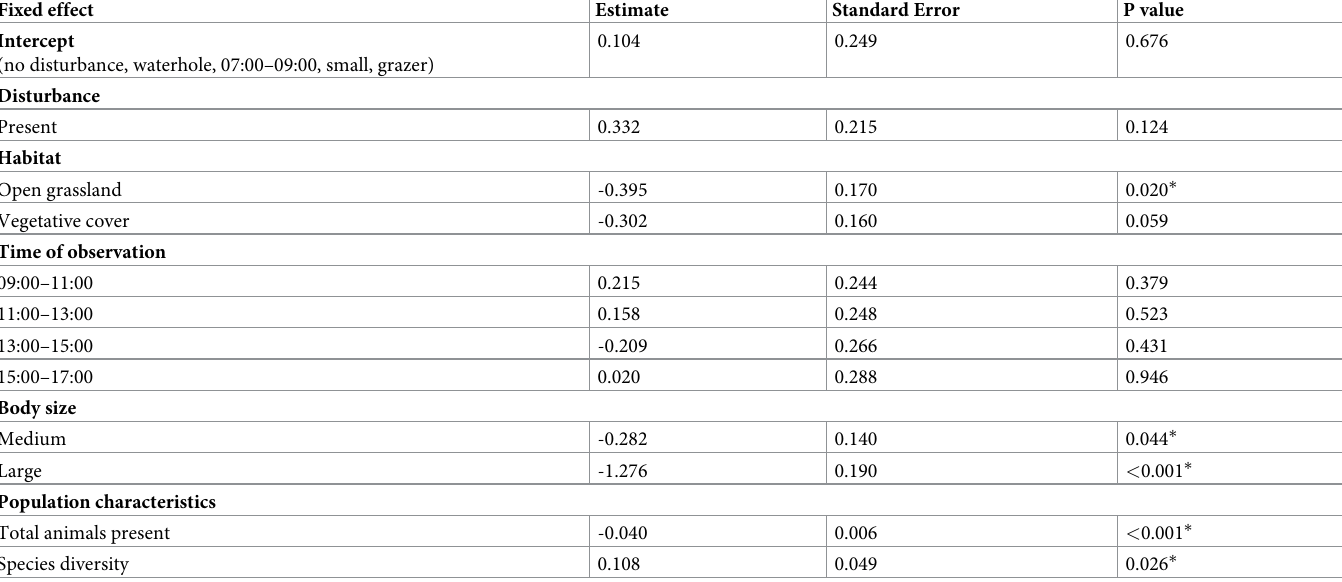
Table 5. Coefficients and p-values for the negative binomial GLMM investigating the influence of habitat type, feeding ecology, body size, time of day, total animals present, and species diversity on rates of vigilance in the